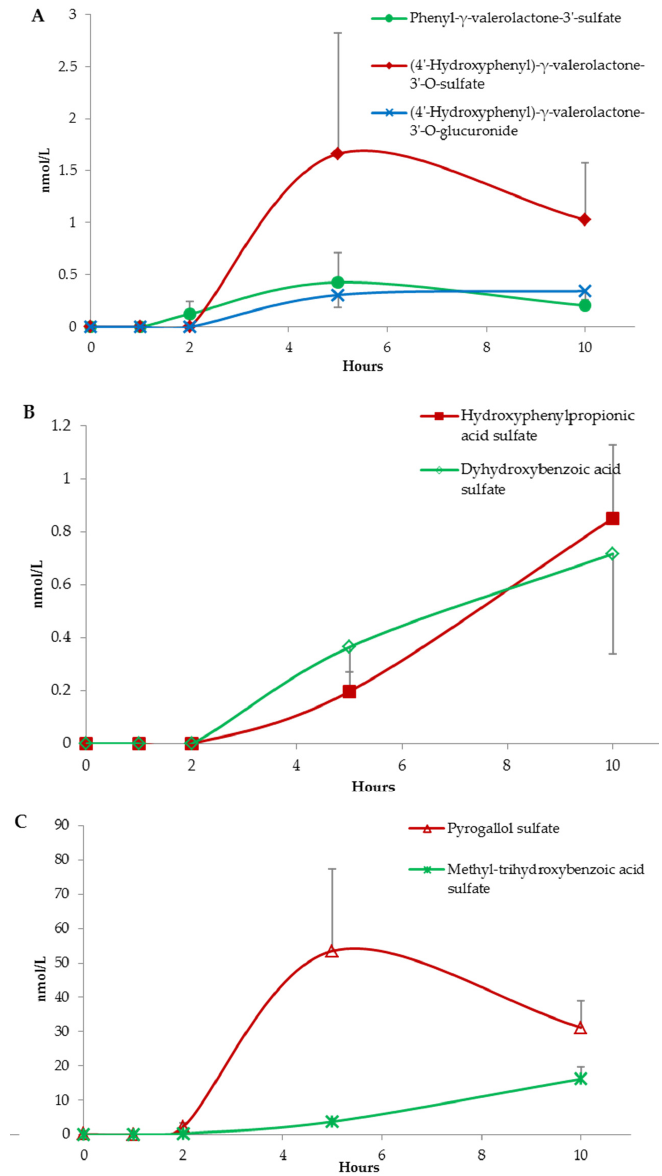
Figure 4. Absorption curves of phenyl ‐γ‐ valerolactone ‐ 3 ′‐ O ‐ sulfate, (4 ′‐ hydroxyphenyl) ‐γ‐ valerolactone ‐ 3 ′‐ O ‐ sulfate, and (4 ′‐ hydroxyphenyl) ‐γ‐ valerolactone ‐ 3 ′‐ O ‐ glucuronide in graph ( A ); hydroxyphenylpropionic acid sulfate and (dihydroxybenzoic acid sulfate in graph ( B ); and pyrogallol sulfate and methyl ‐ trihydroxybenzoic acid sulfate in graph ( C ). Data are expressed as mean values and bars represent standard error of means (SEM).